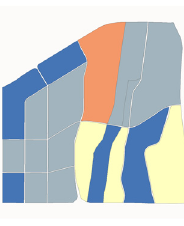
Figure 12. Simulation diagram of CO 2 concentration distribution under different schemes. ( a ) cur- rent situation. ( b ) experiment A. ( c ) experiment B. ( d ) experiment